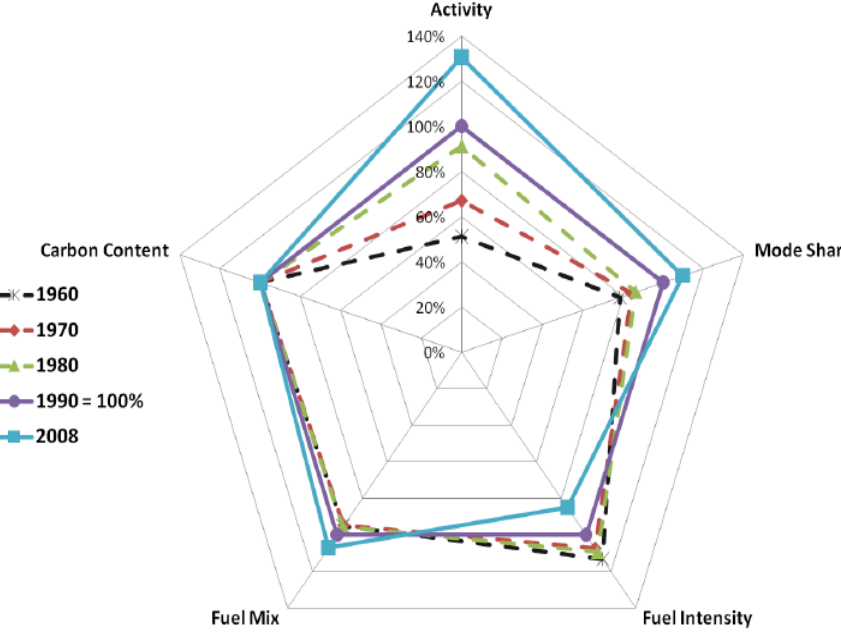
Figure 10. LMDI decomposition results for the passenger sector.